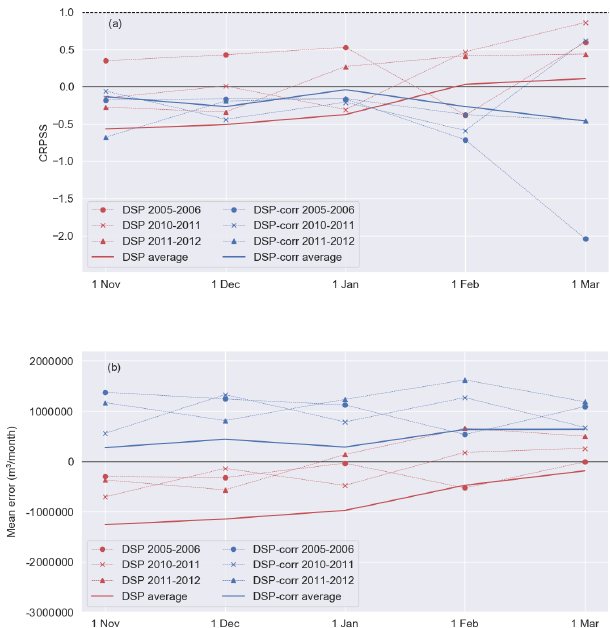
Figure 3. Skill of the hydrological forecast ensemble (inflow to reservoir S1) during the pumping licence window (1 November– 1 April) measured by the CRPSS (a) and the mean error (b) . For each time step, the skill is averaged over all the forecasts available from that moment to the end of the pumping window (1 April). Red lines represent the skill without bias correction of the meteorolog- ical forcing (ECMWF seasonal forecasts), and blue lines represent the skill after bias correction. Solid lines represent the average skill over the period 2005–2016, while circles, crosses and triangles rep- resent the skill in three particularly dry winters (November–April). CRPSS = 1 corresponds to a perfect forecast, and CRPSS = 0 corre- sponds to a forecast that has no skill with respect to the benchmark